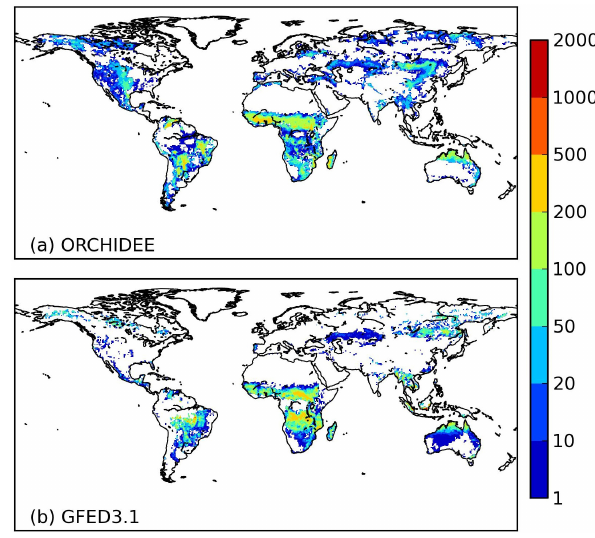
Figure 5. Fuel consumption (g C per m 2 of area burned) aver- aged over 1997–2009 by (a) ORCHIDEE simulation and (b) the GFED3.1 data.